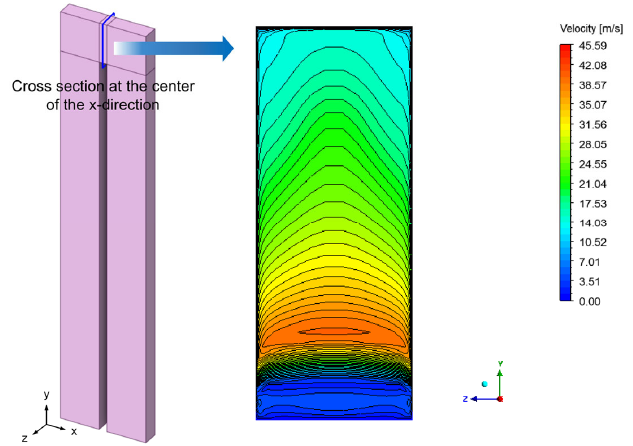
Figure 8. Velocity contour at the center of the x-direction (Re = 24,230).